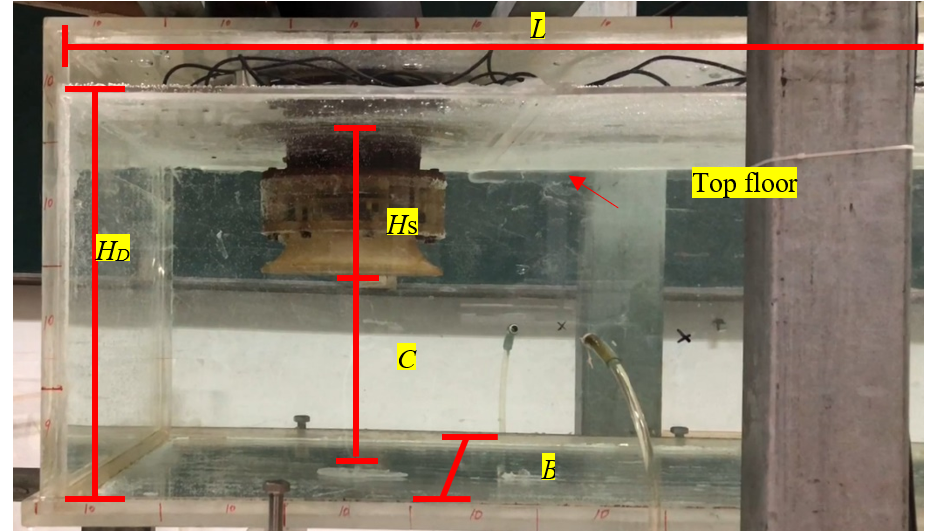
Figure 23. Geometric parameters of the closed sump in the test model.